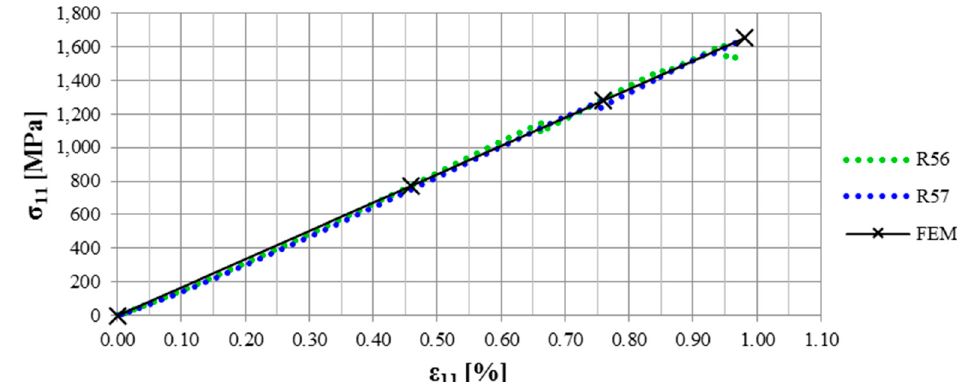
Figure 11. Verification of the FEA. The nodal stresses and strains in the centre of the shaft were taken from the FEA and compared to the experimental results. The fibre parallel shaft strains were measured with strain gauges.